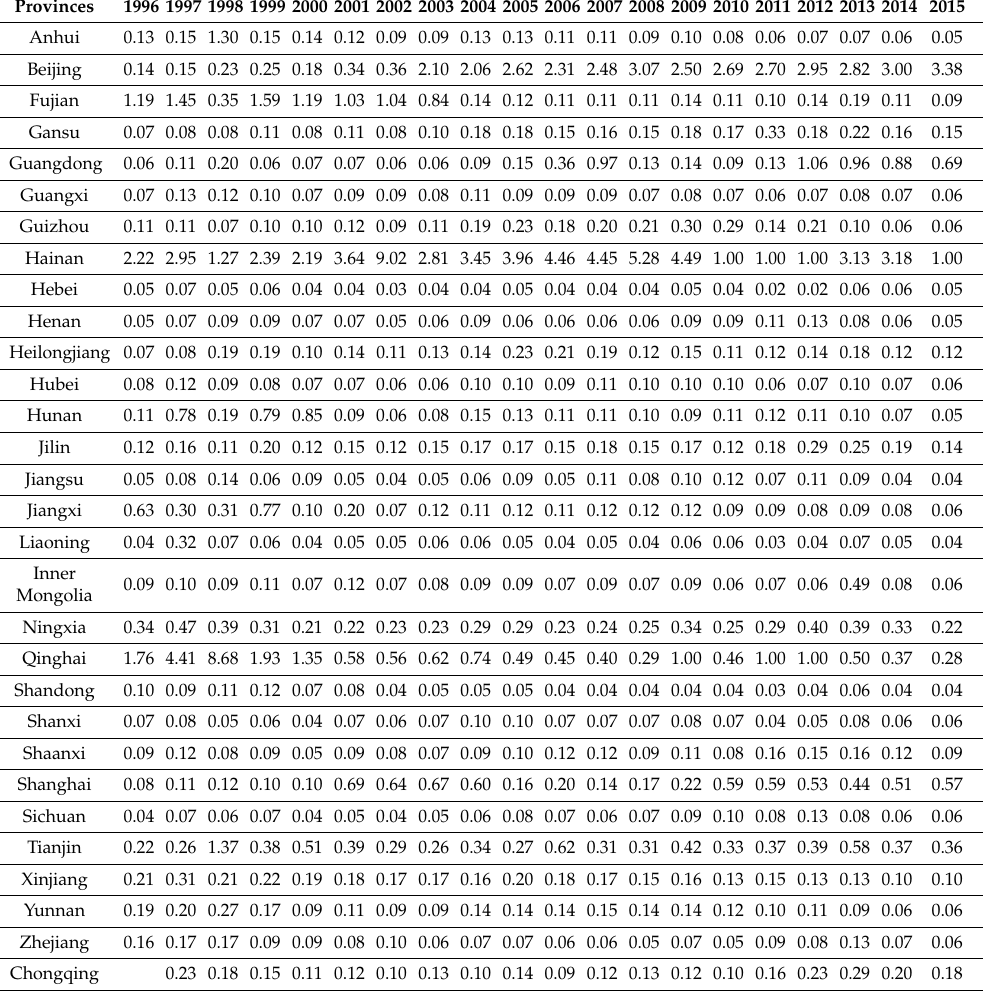
Table A2. China’s provincial environmental treatment e ffi